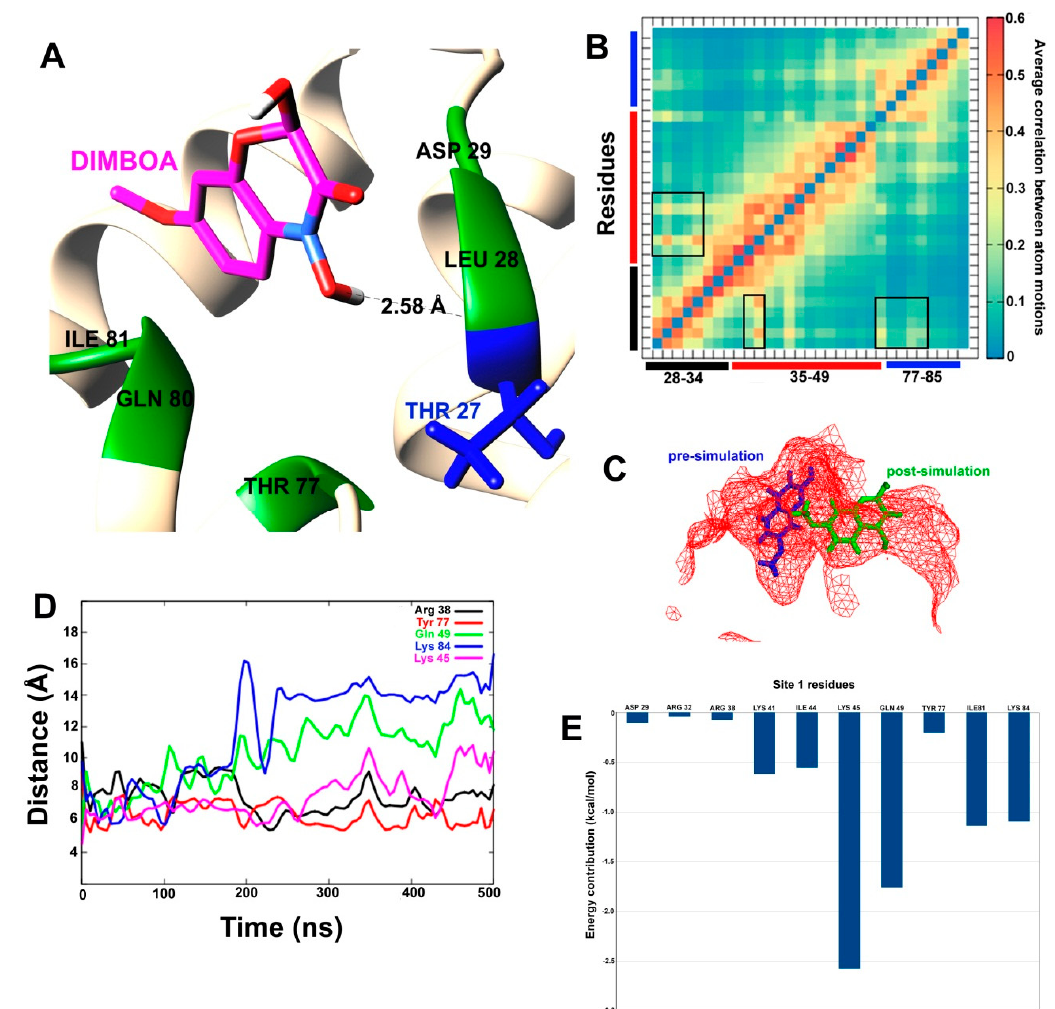
Figure 5. ( A ) The post-simulated interaction between DIMBOA and SlitCSP3 at site 1. ( B ) Heat map of average correlation between atomic motions calculated for site 1 amino acid residues. The black, red, and blue bars represent the three sides of the triangular binding site. The boxes highlight correlated motions between residue pairs. ( C ) The relative position of pre- and post-simulated SlitCSP3–DIMBOA complexes. ( D ) Distances (in Å) calculated for every 100th simulation frame between selected residues of site 1 and DIMBOA. ( E ) MM / PBSA-based residue-wise contribution to the binding energy.